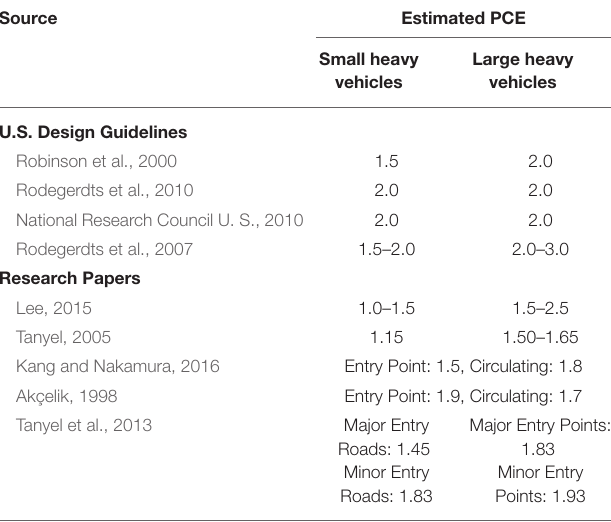
TABLE 1 | Summary of passenger car equivalents for